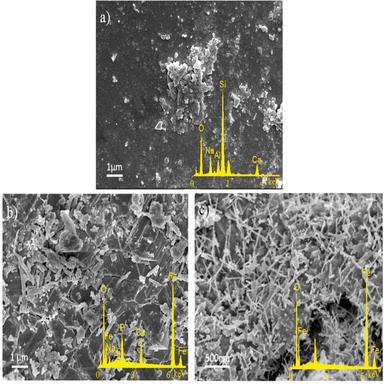
Surface morphology of IBA particle from (a) NF-G and (b, c) F.